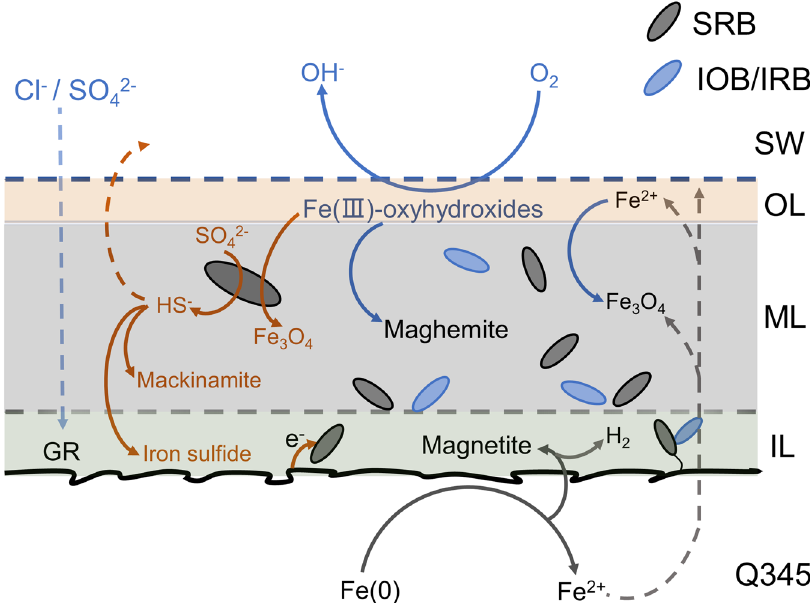
Fig. 9 Schematic diagram of the major corrosion products for Q345 carbon steel in a long-time seawater corrosion. Under the in fl uences of these complex microbial communities and the marine environment, three relatively stable rust layers were formed. Magnetite (Fe 3 O 4 ) and small amounts of iron sul fi de and green rust were identi fi ed in the IL. The ML was predominantly composed of maghemite ( γ -Fe 2 O 3 ), together with Fe3O4 and mackinamite. The OL contained Fe(III)-oxyhydroxides ( α -FeOOH and γ -FeOOH), along with a large number of fouling organisms attached to the surface. In all of the rust layers, anaerobic SRB were found to play an important role in the formation of the corrosion